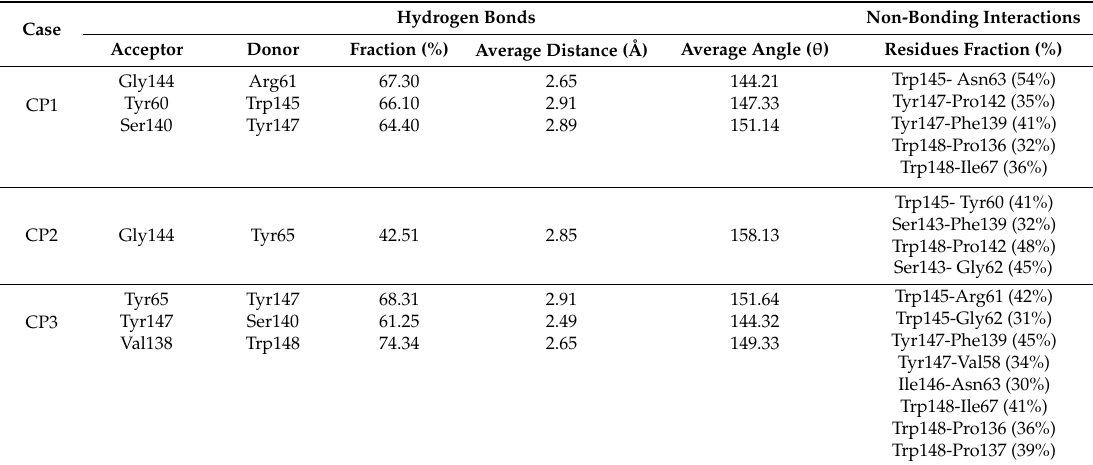
Table 6. Binding modes of UEV domain protein with the cyclic